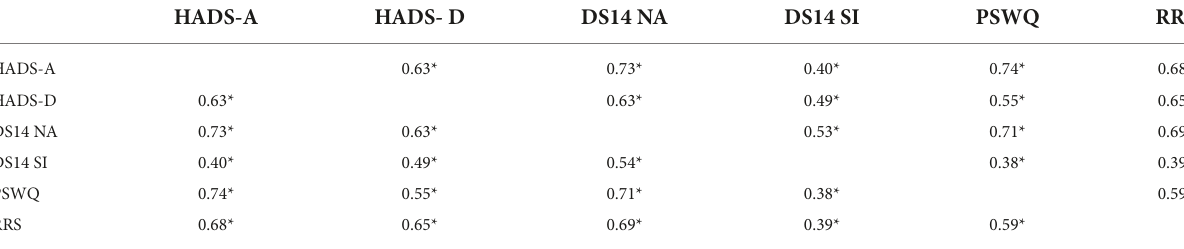
TABLE 2 Correlations between anxiety, depression, negative affectivity, social inhibition, worry and rumination ( n = 904).